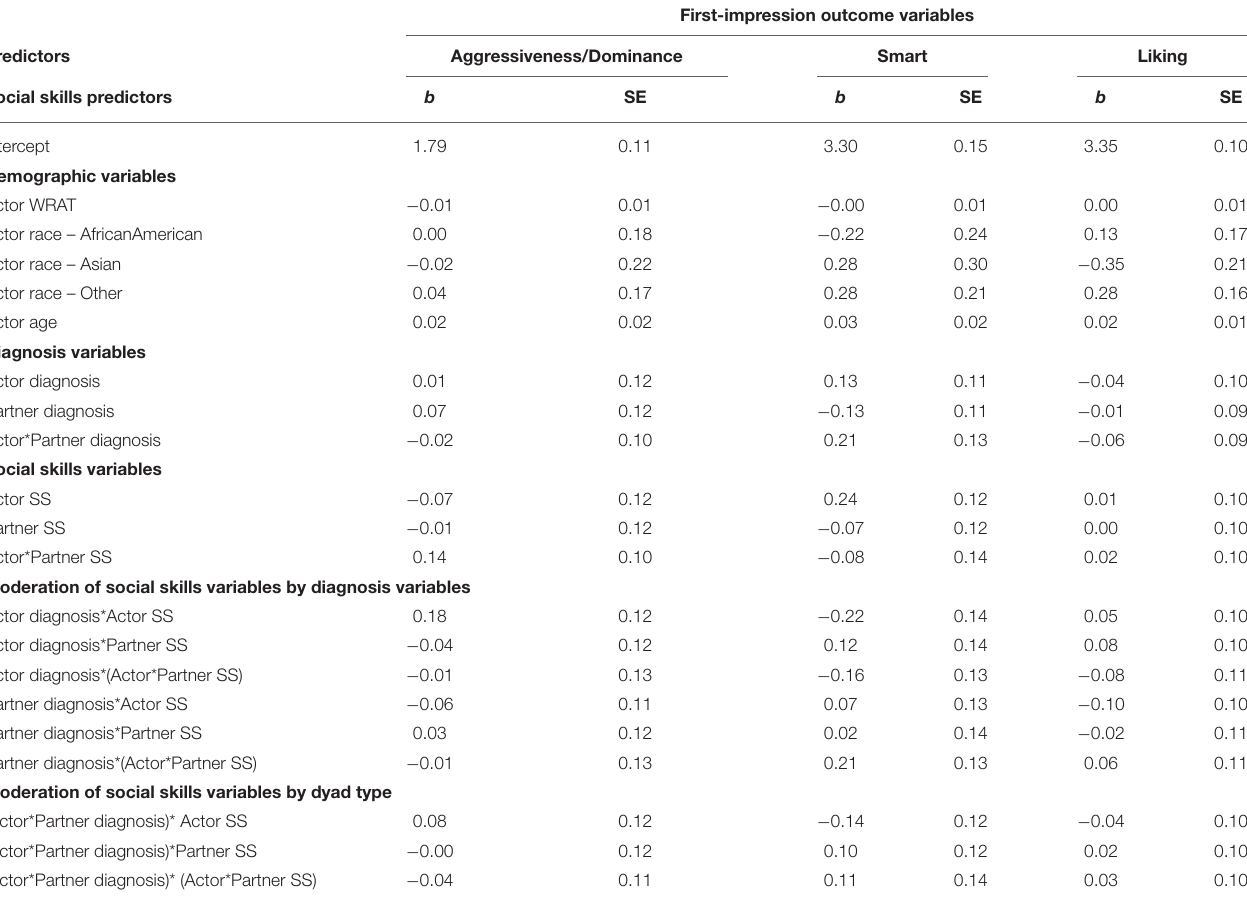
TABLE 14 | Actor-partner interdependence model analyses estimating the combinatorial effects of diagnostic status and social skills variables on the first impression variables of aggressiveness/dominance, smartness, and